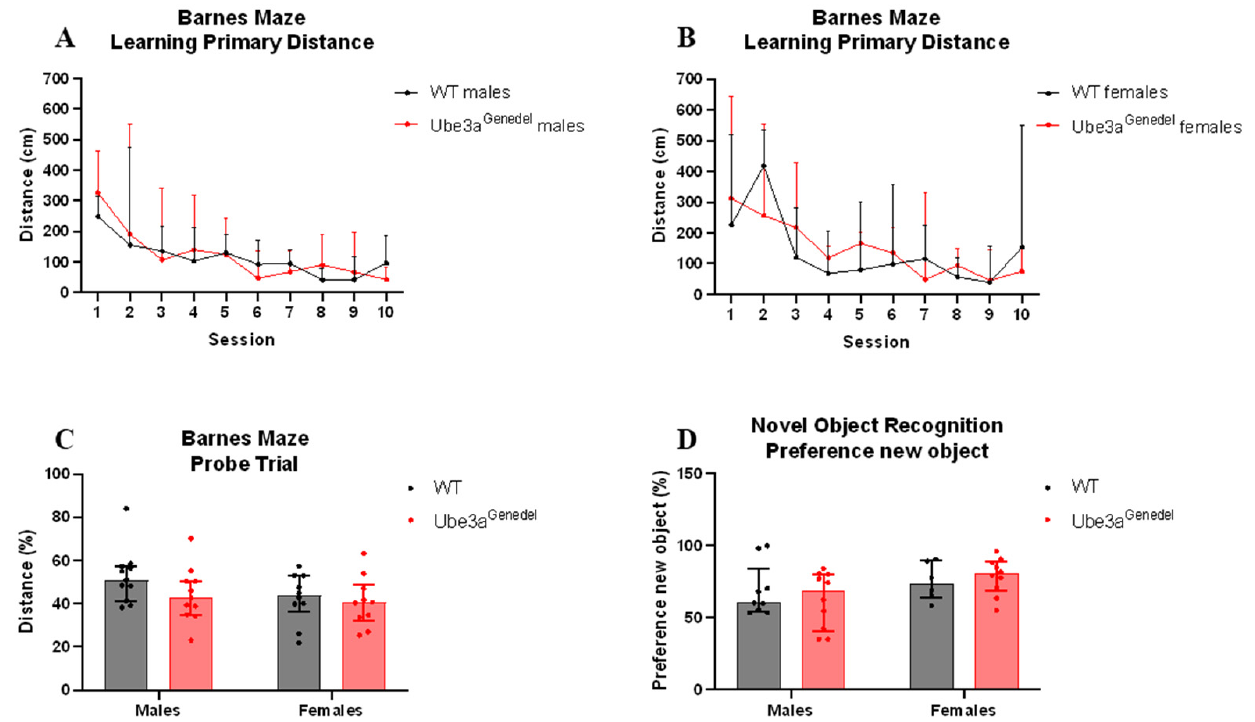
Figure 5. Learning and memory assessment. ( A – C ) The durations of the learning phase and probe trial were not significantly altered between genotypes; robust ANOVA of aligned rank transformed data with dependent measurement, p > 0. ( D ) No significant differences in the percentage of time spent with a new object between the genotypes, robust ANOVA of aligned rank transformed data with dependent measurement main effect, p > 0. All data represent medians with interquartile ranges.